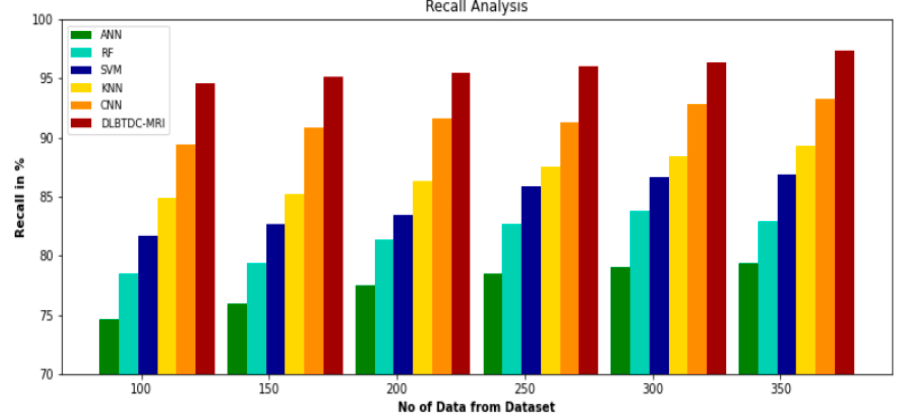
Figure 8. Recall analysis of DLBTDC-MRI method with existing system. Figure 7. Recall analysis of DLBTDC-MRI method with existing system. Table 5. Recall analysis of DLBTDC-MRI method with existing system. No Data of Dataset